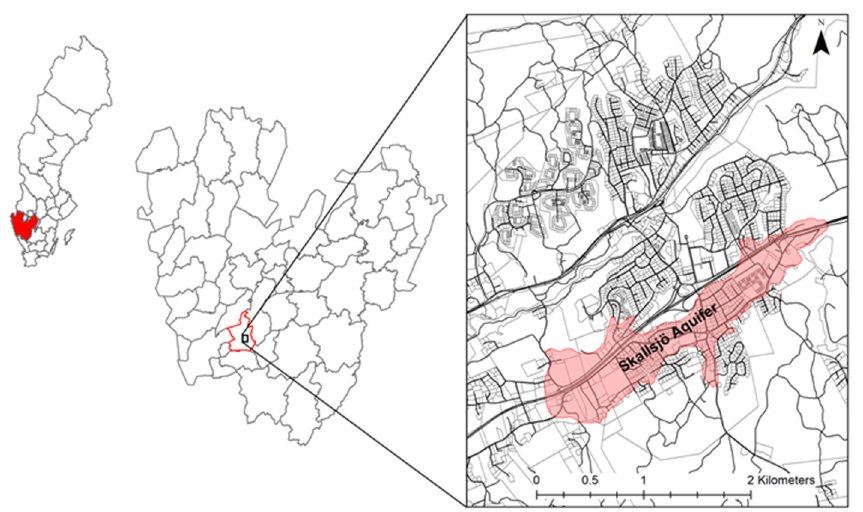
Figure 4. Location of the case study area. The Skallsjö aquifer is located in Lerum Municipality in Västra Götaland County in Sweden.